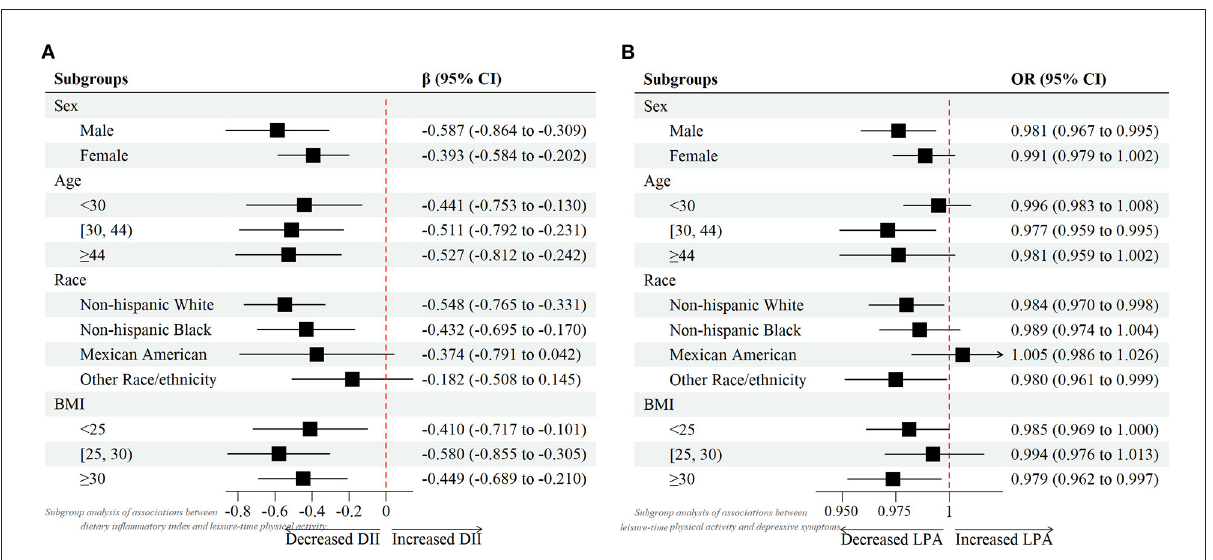
FIGURE1 Forest plots of (A) associations between dietary inflammatory index and leisure-time physical activity. (B) associations between leisure-time physical activity and depressive